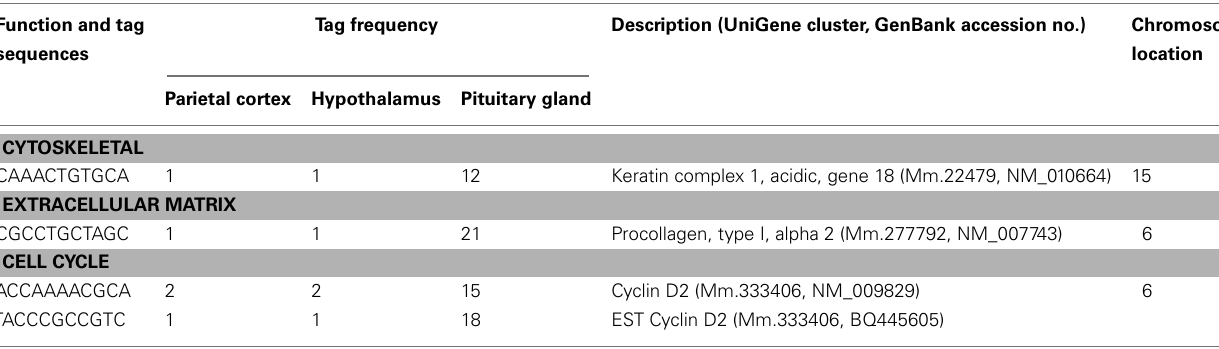
Table 6 | Components of cell structure and division preferentially in the